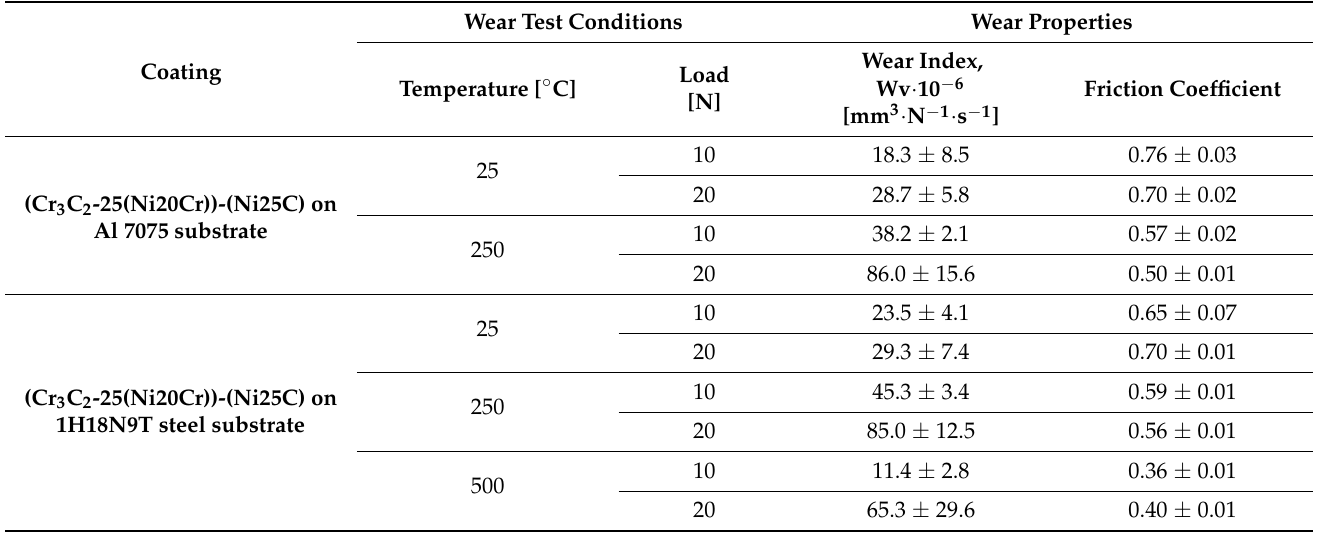
Table 4. The wear index and friction coefficient of the (Cr 3 C 2 -25(Ni20Cr))-(Ni25C) coatings deposited on different substrates and determined under various